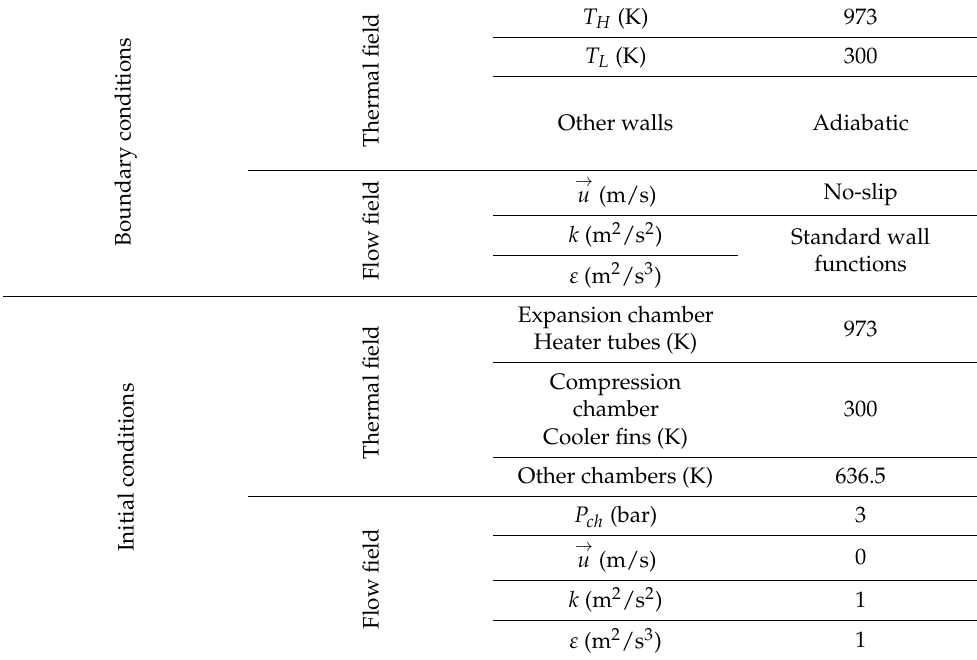
Table 2. Initial-boundary